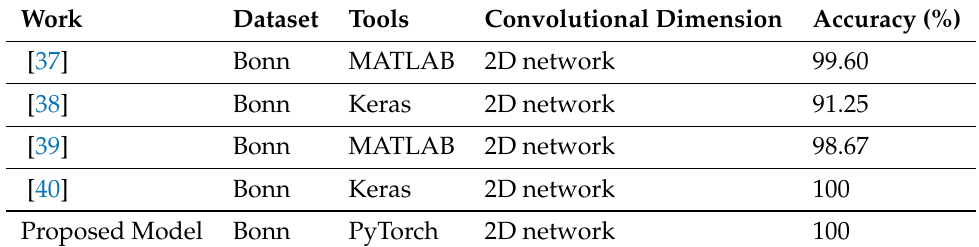
Table 13. Accuracy of some seizure detection methods on the Bonn dataset.